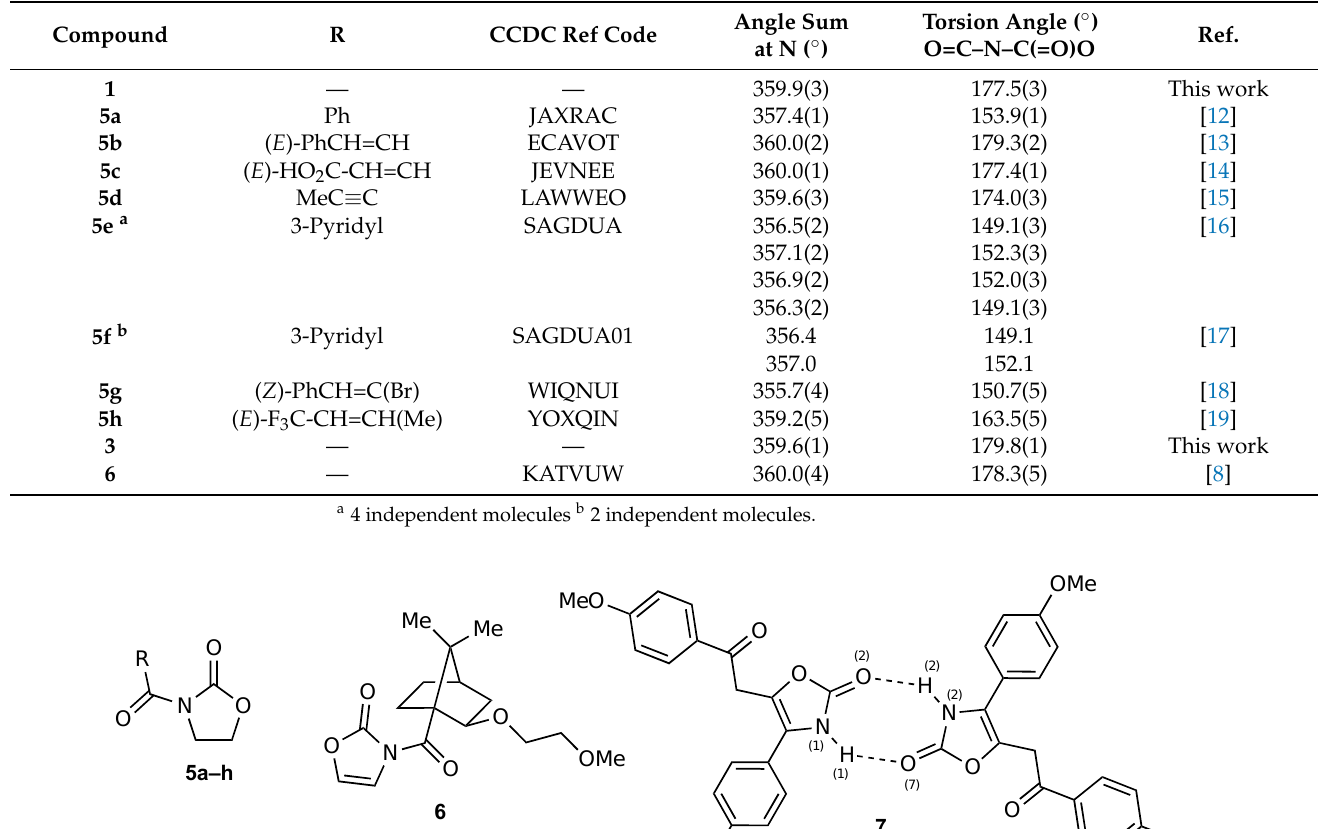
Table 2. Geometrical parameters for 1 and 3 and comparison compounds 5a – h and 6 .